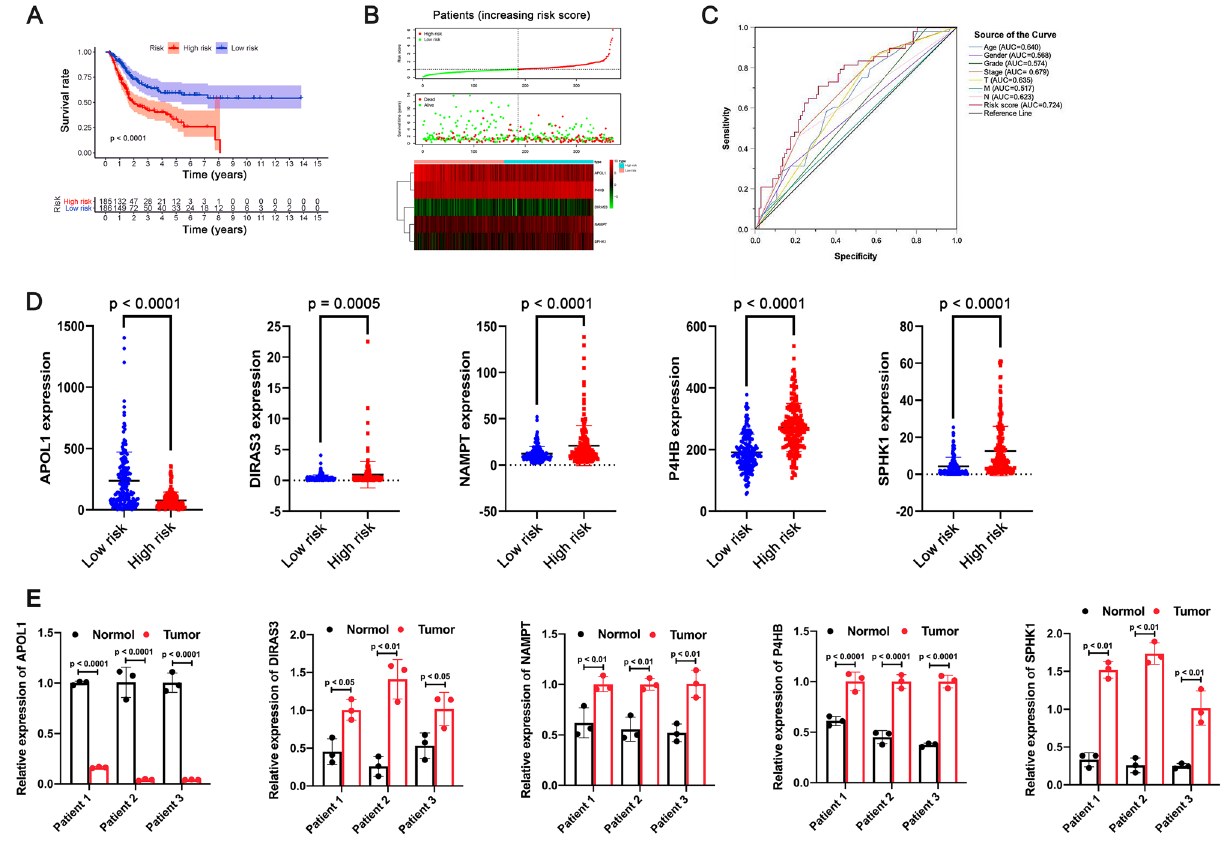
Figure 3. Prognostic value of present risk model. ( A ) Survival analysis between high-risk and low-risk groups. The 95% confidence interval was shown as a light-colored background around the Kaplan–Meier curve. ( B ) Risk plot encompassing the distribution of risk score, survival status, and risk genes expression of each patient. ( C ) ROC curve analysis of different variables. female = 1, male = 0. ( D ) Expression level of the five selected PDEARGs between low-risk and high-risk group. ( E ) Expression level of the five selected PDEARGs between tumor and adjacent normal tissue (n = 3). Data are presented as the means ± SD from 3 independent experiments.